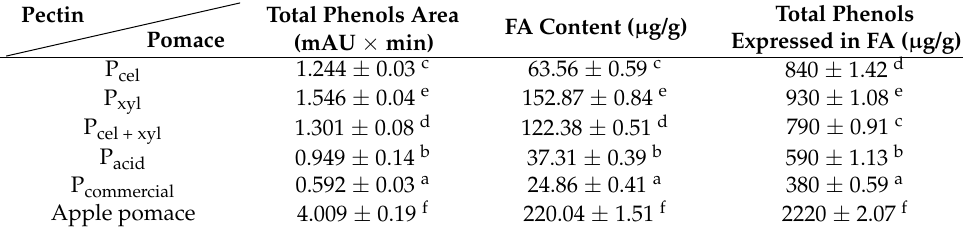
Table 1. The content of ferulic acid (FA) and total phenolic compounds in apple pectin and apple pomace. Total Phenols Pectin Total Phenols Area FA Content ( µ g/g) Pomace Expressed in FA ( µ g/g) (mAU × min) P